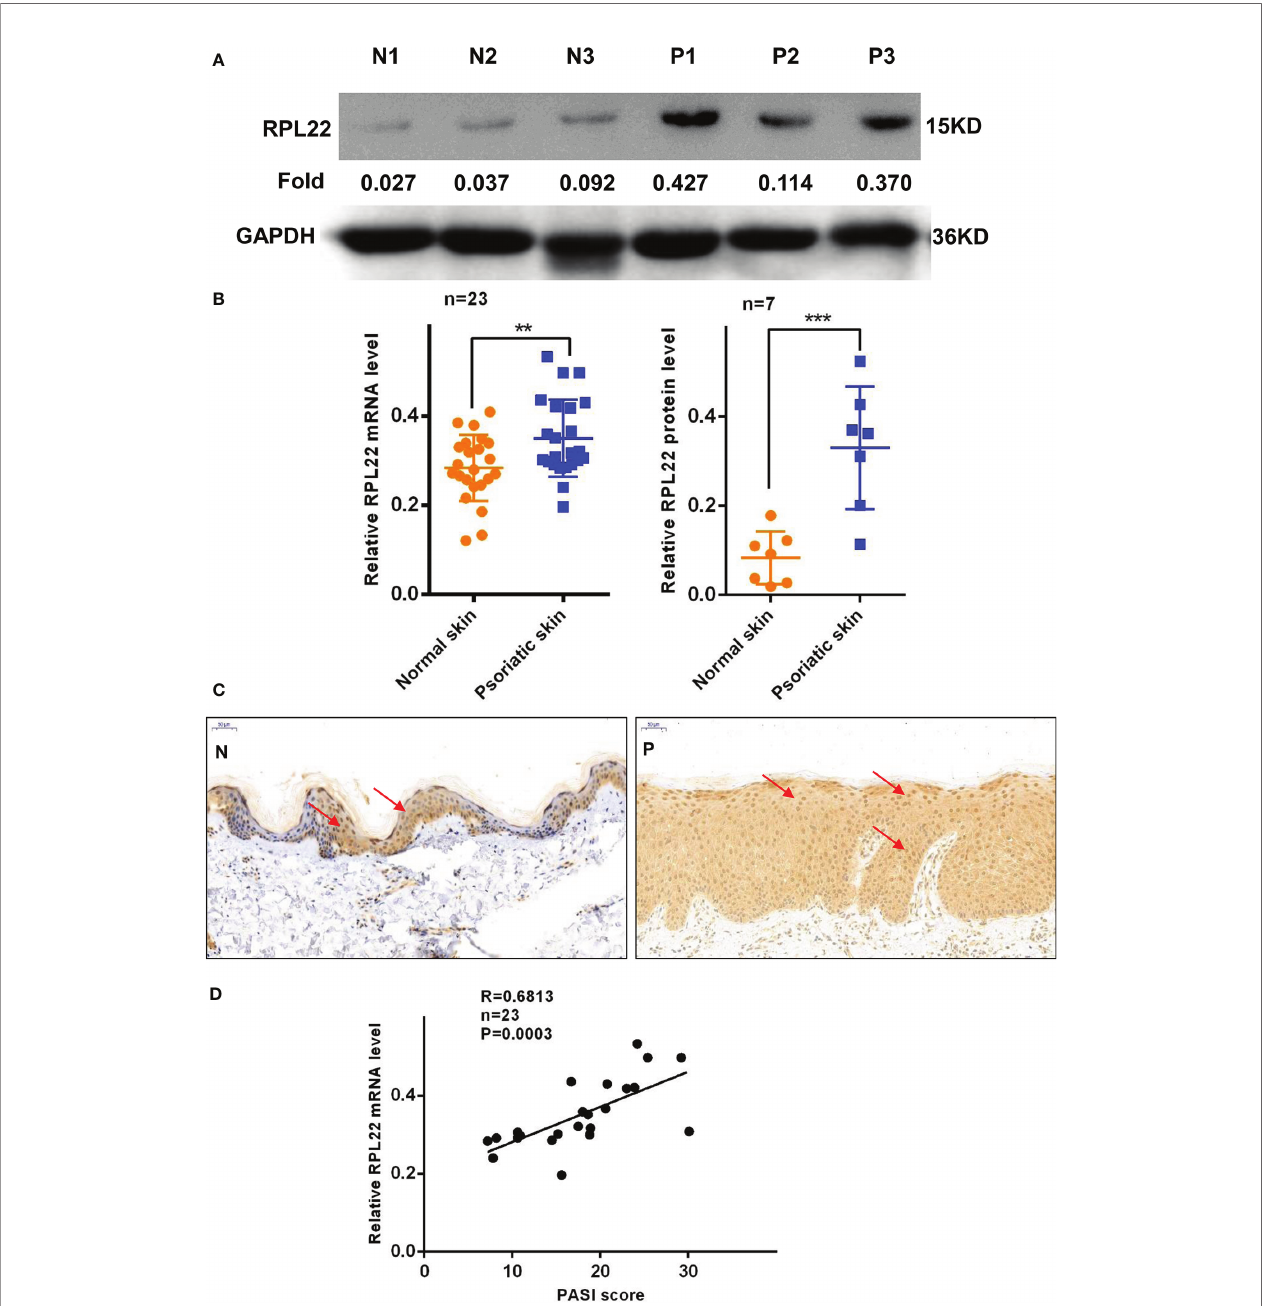
FIGURE 1 | RPL22 expression is elevated in skin lesions of psoriasis patients. (A) The protein expression level of RPL22 in skin lesions derived from psoriasis patients and healthy controls. (B) The statistical analysis of the relative mRNA (left panel, n = 23) and protein expression levels(right panel, n = 7) of RPL22 in skin lesions derived from psoriasis patients and healthy controls. (C) IHC staining of RPL22 in skin lesions derived from psoriasis patients and healthy controls. (D) Correlation of human RPL22 mRNA expression in psoriatic skin with PASI scores (n = 23). Data represent the mean ± SEM. **P < 0.01, ***P < 0.001. Two-tailed unpaired Student ’ s t test was